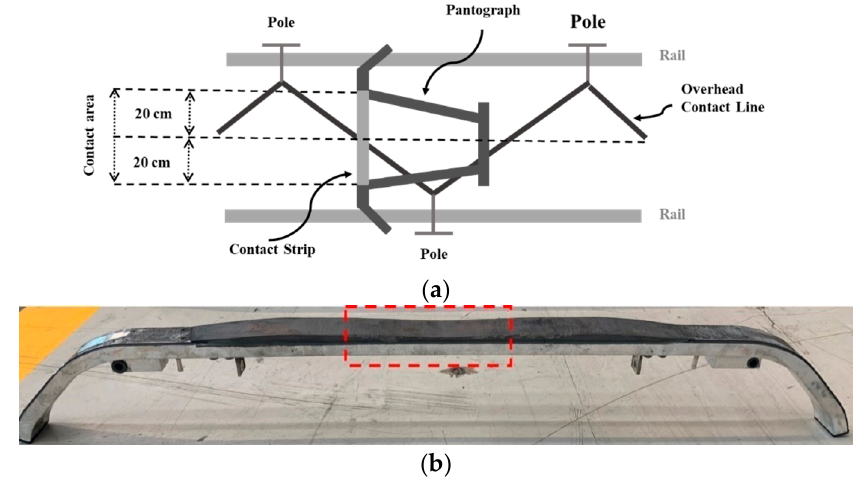
Figure 1. Contact strip of the pantographs used in high-speed electric railway vehicles. ( a ) Schematic diagram of contact area (top view). ( b ) Actual picture of contact strip showing wear condition.